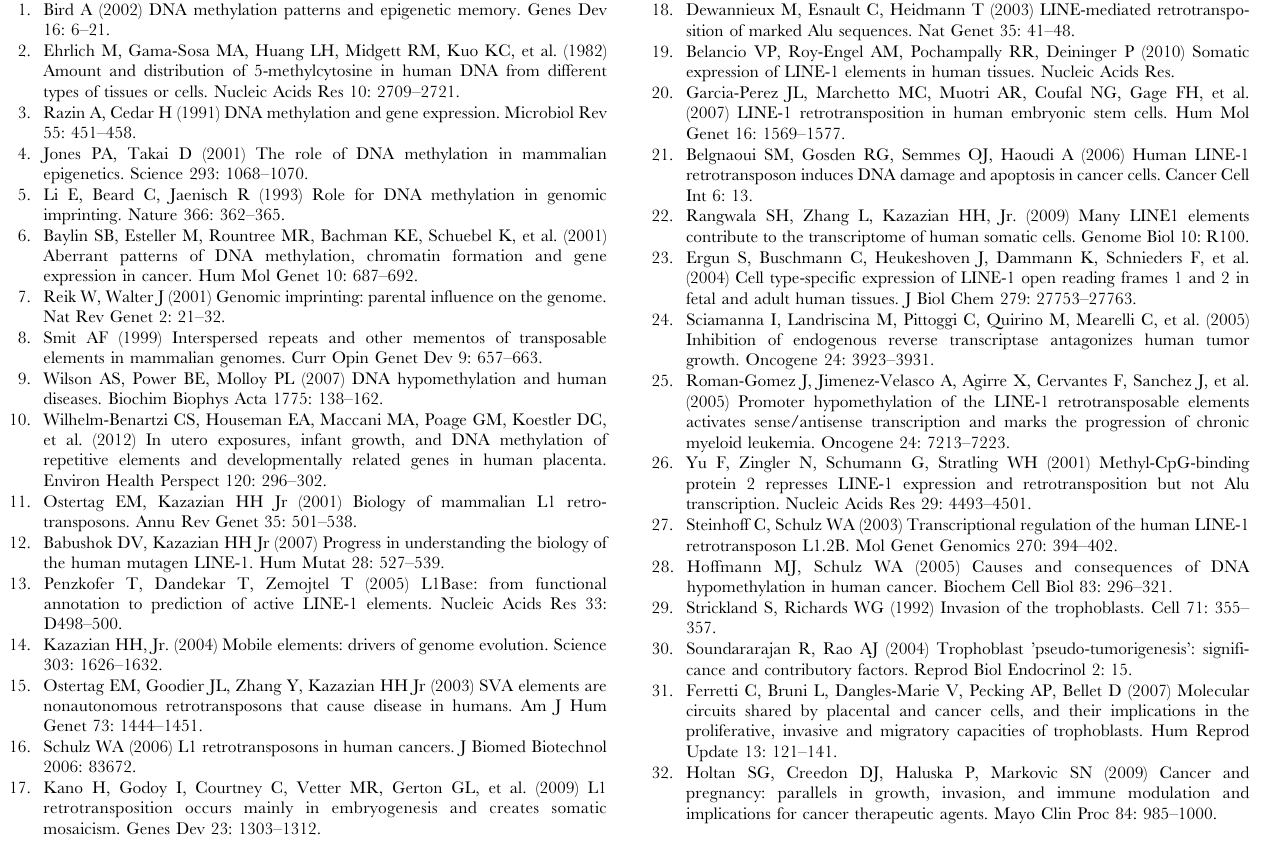
(TIF) Figure S2 Results of COBRA on LINE-1 methylation. LINE-1 is hypomethylated in 3N placentas (Mean: 30.2%) relative to 1N placentas (Mean: 59.3%). * P , 0.05. Open circle ( # ): placental samples of 1N; Open triangle ( g ): placental samples of 3N. Note the two samples of 1N groups with substantial lower levels of LINE-1 methylation. (TIF) Figure S3 Spearman correlation analyses showed that no significant correlation between LINE-1 methylation levels and gestation ages were detected in either 1N (A) or 3N (B) placentas when the two groups were analyzed separately.